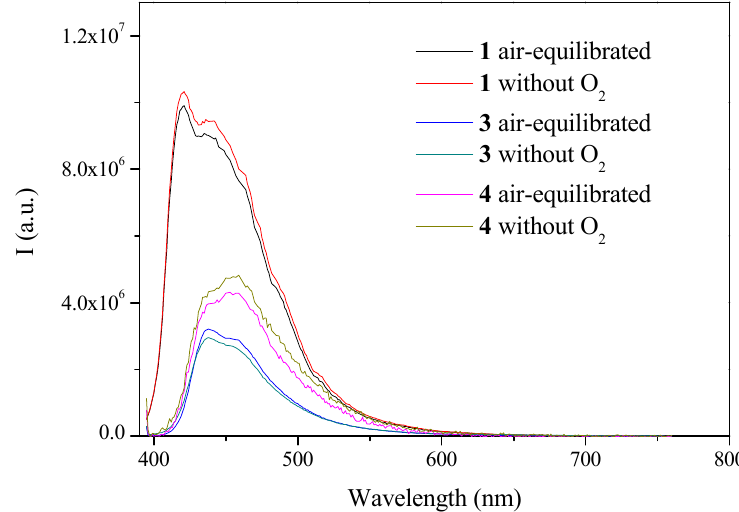
Figure 2. Emission spectra of 1 × 10 − 5 M of the compounds 3 and 4 and of the free ligand 1 in dichloromethane with and without oxygen ( λ exc = 345 nm).